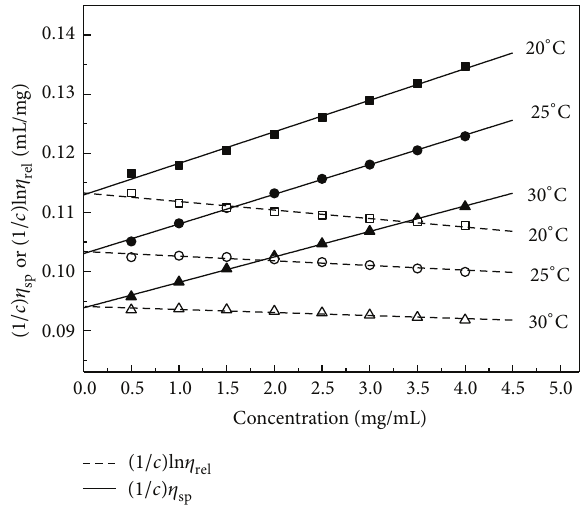
Figure 2: Huggins and Kraemer viscosity functions from dilute to extremely dilute PEOX solutions.